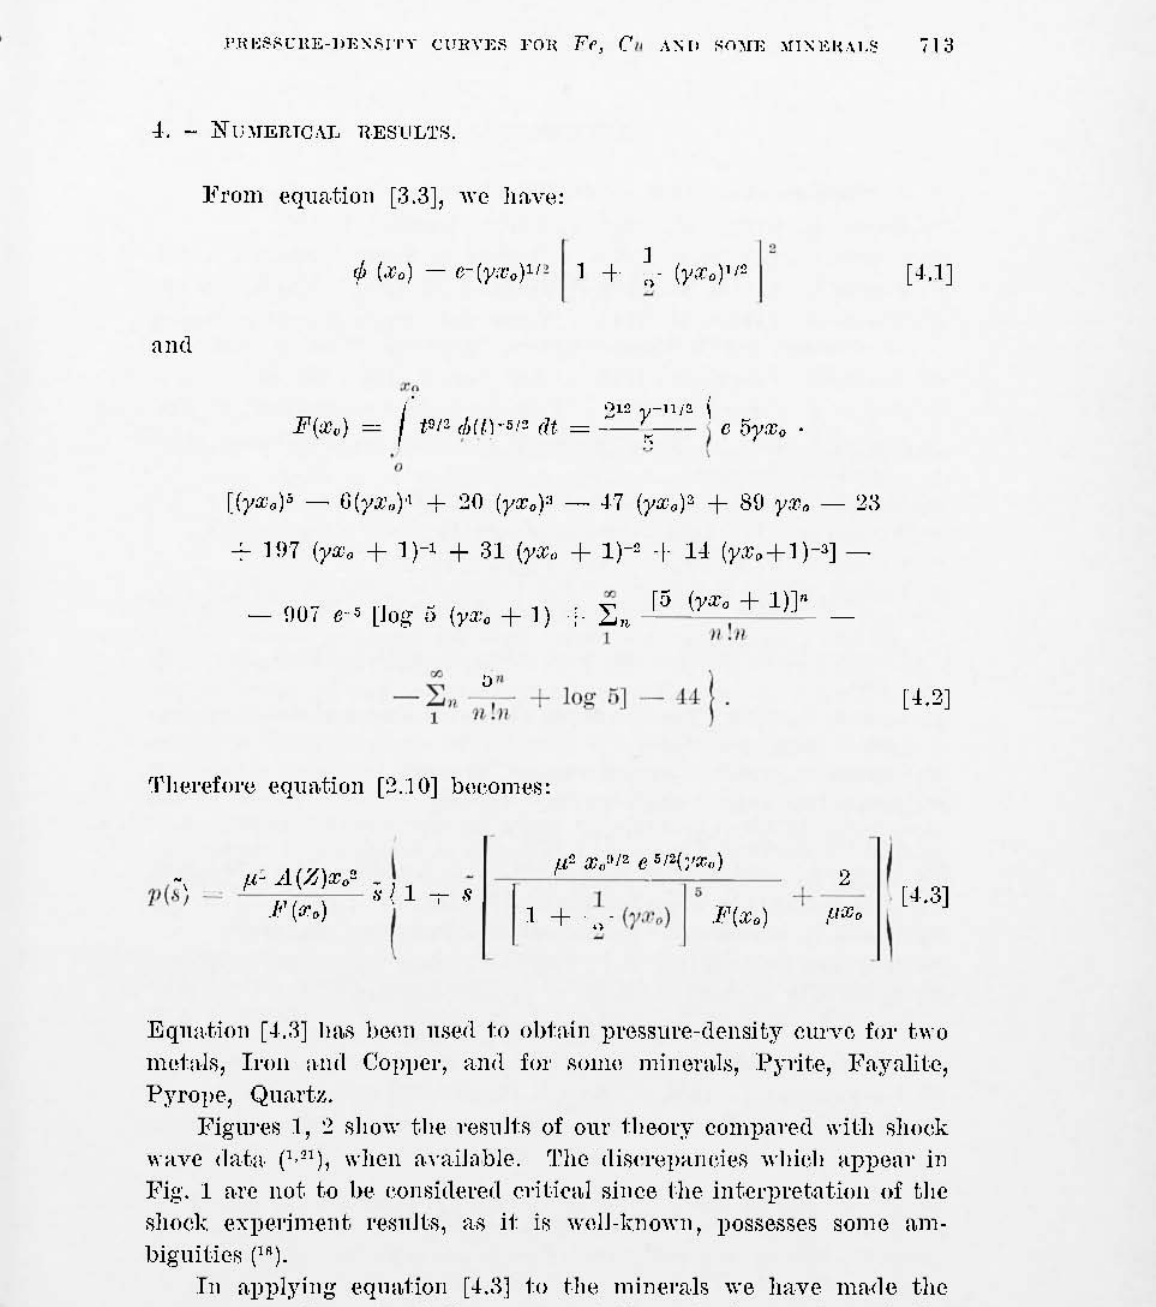
Figures 1, :! show the results of our theory comparcd with shock wavc dat·a· ('.n), whcn anlilablc. Fig. l arc not t.o be ('onsidercd crit.ical sillce thc intcl'prct.atioll of thc shock. expel'imellt. l'esnlt.s, as it is wolJ-kl10'\-ll, possesscs somc am biguit.ics